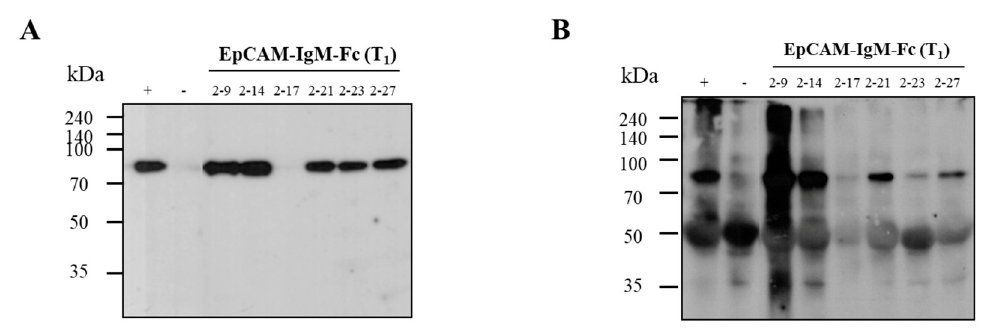
Figure 6. Immunoblot analysis to confirm the expression of EpCAM–IgM Fc in representative T1